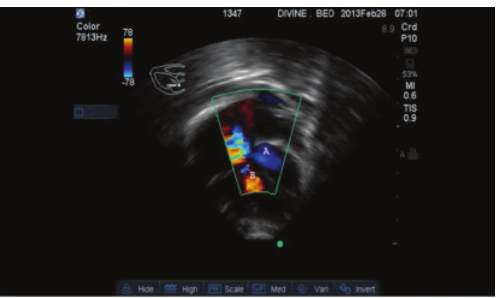
Figure 1: Color flow Doppler from an apical four-chamber view showing systolic flow from LV to RA though the adherent septal and anterior tricuspid leaflets. Note the Gerbode jet (A) and the VSD jet (B).